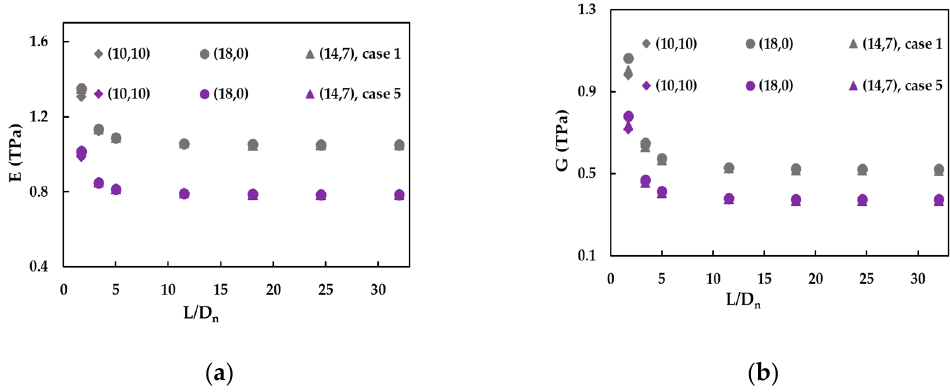
Figure 11. The evolutions of the ( a ) Young’s and ( b ) shear moduli, with the nanotube aspect ratio, L/D n , for the cases 1 and 5 of (10, 10), (18, 0) and (14, 7) SWBNNTs.